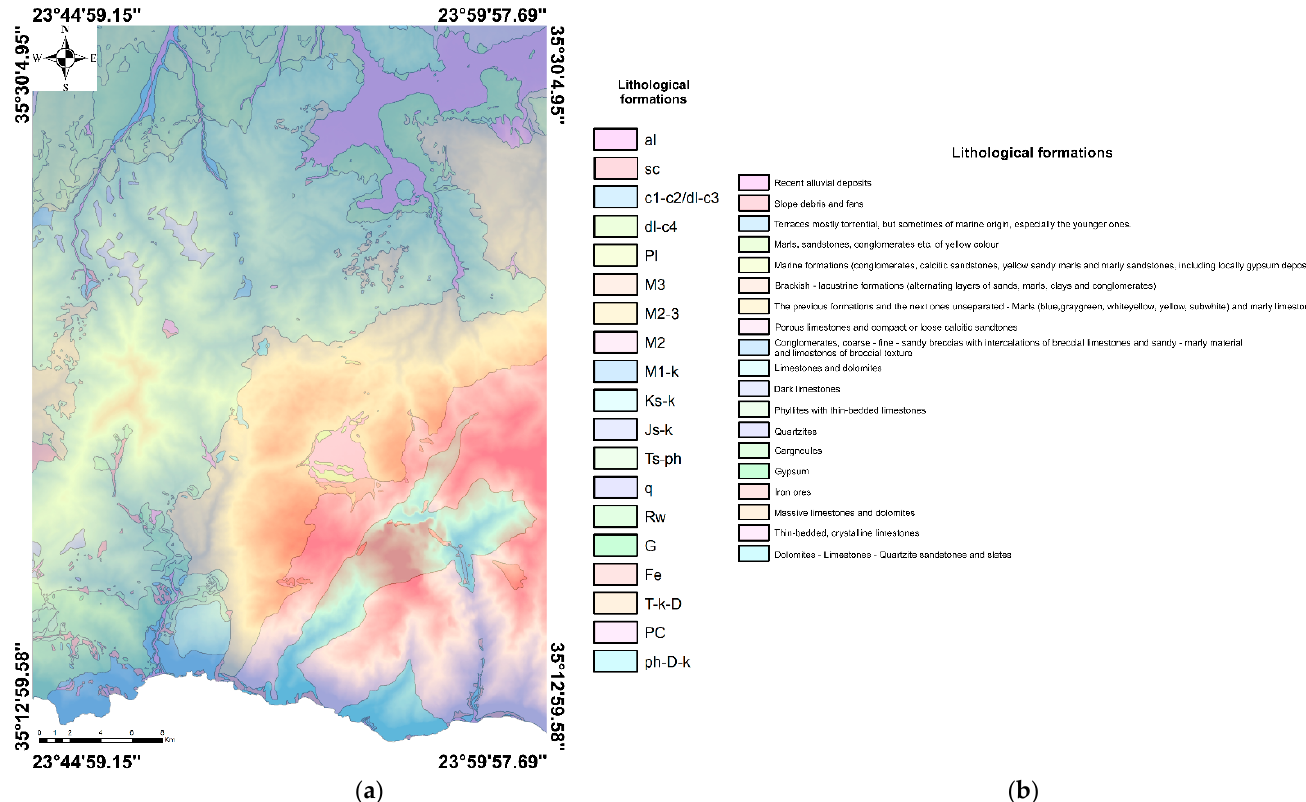
Figure 4. The geological model for the wider Samaria Gorge modified from Tataris and Christodoulou [3]—1st geological model: ( a ) Lithological map of the study area; ( b ) Description of the geological formations.